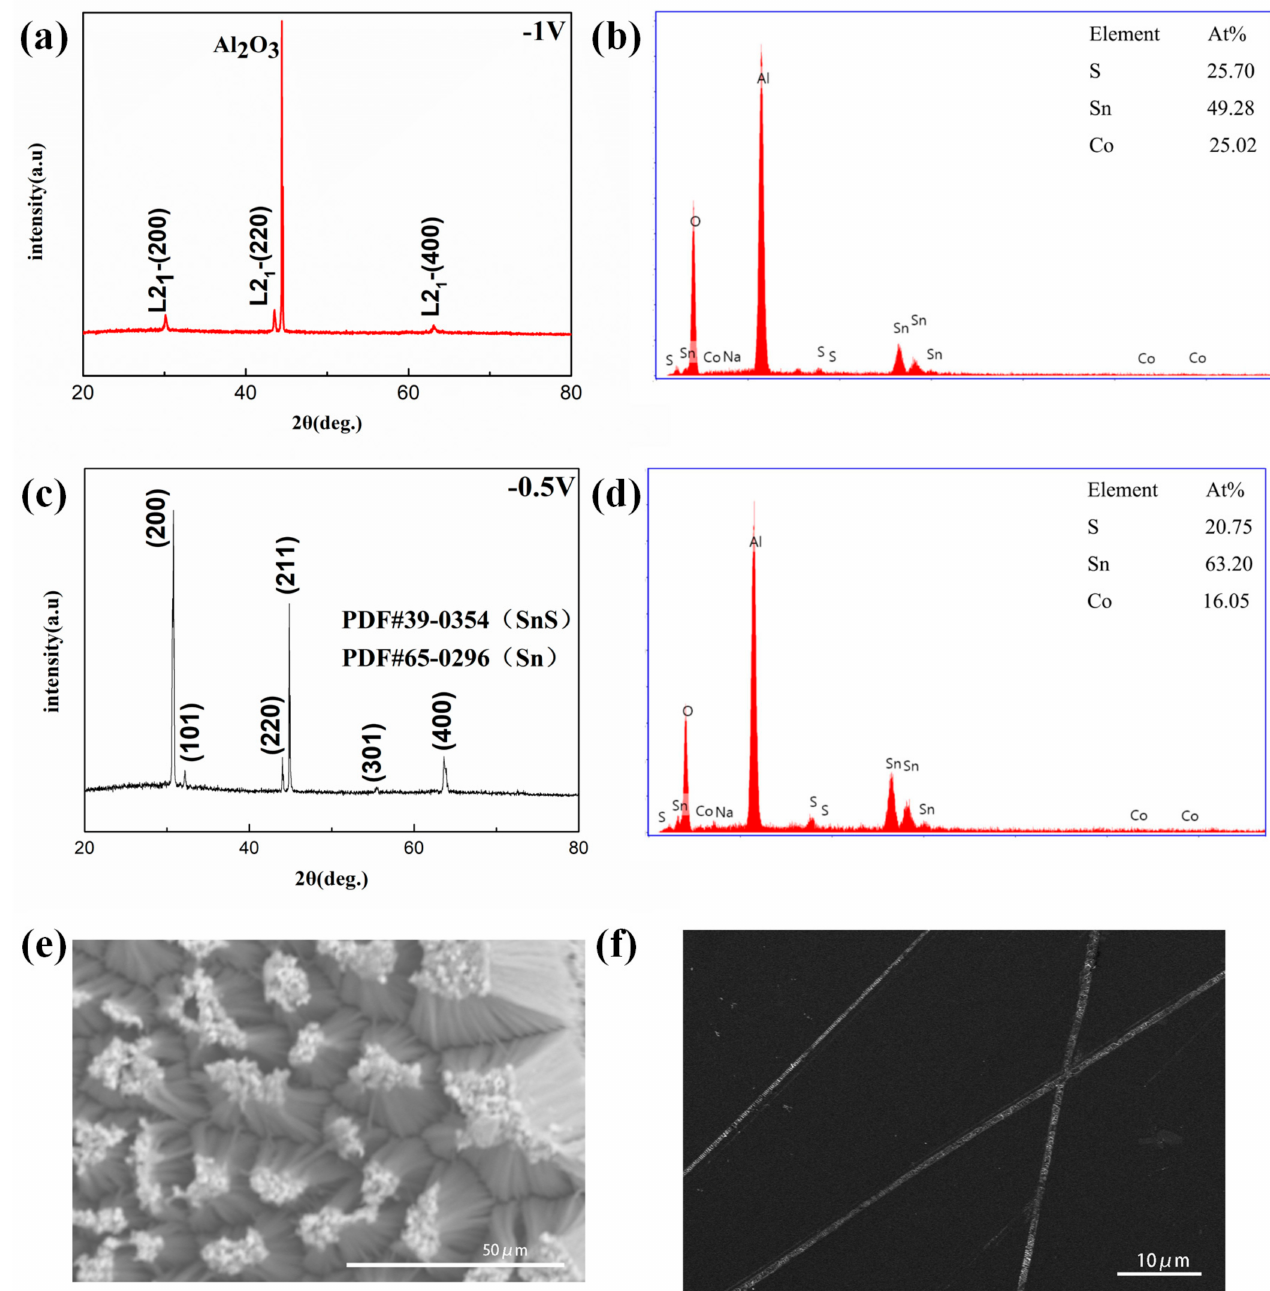
Figure 6. ( a ) The X-ray diffraction patterns of Sn 2 CoS nanowires prepared at − 1 V. ( b ) EDX spec- troscopy of nanowires at − 1 V. ( c ) The X − ray diffraction patterns of Sn 2 CoS nanowires prepared at − 0.5 V. ( d ) shows EDX spectroscopy of nanowires at − 0.5 V. ( e ) Typical image of nanowire array by SEM. ( f ) The image of single nanowire by